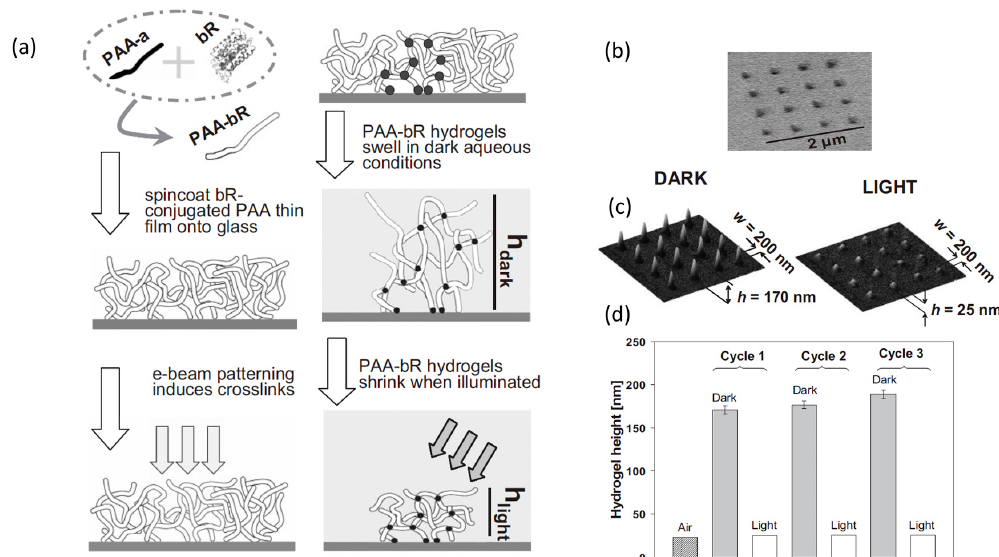
Figure 4. ( a ) Preparation of photo-responsive nanopatterned hydrogels by electron-beam lithography (EBL) using an amine-terminated poly(acrylic acid) conjugated to a protein, bacteriorhodopsin (bR) as resist. bR is a green light-driven proton pump found in the purple membrane of Halobacterium halobium . ( b ) SEM image of the hydrogel dot array. ( c ) Contact-mode AFM images of hydrogel arrays after swelling at room temperature in water at pH 9.0. Samples were placed in a fluid cell and imaged before (DARK) and after (LIGHT) illumination by a 514.5 nm light source. ( d ) Average height of the hydrogel dot array in air (patterned bar) and thereafter placed in water at pH 9.0 for three consecutive, cyclic exposures in dark (gray bars) and illuminated conditions (white bars). Adapted from [43].